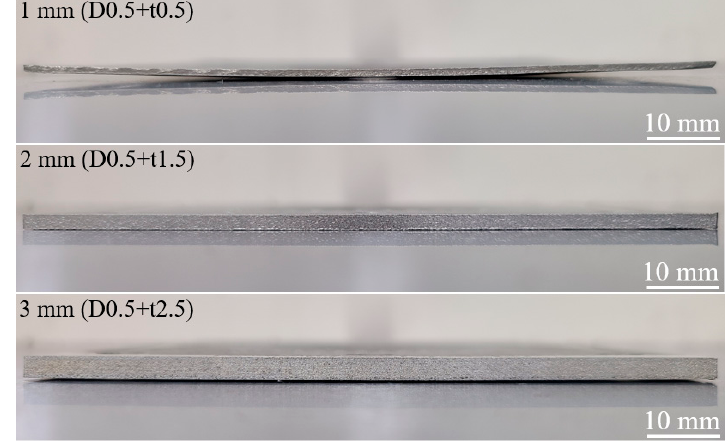
Figure 5. Bending confirmation of three types of PBF-built SUS 316L BPs.